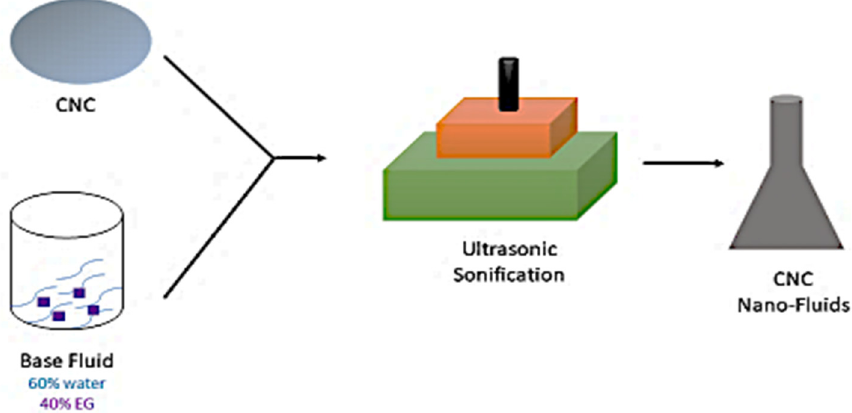
Figure 2. Graphene nanofluids preparation process.